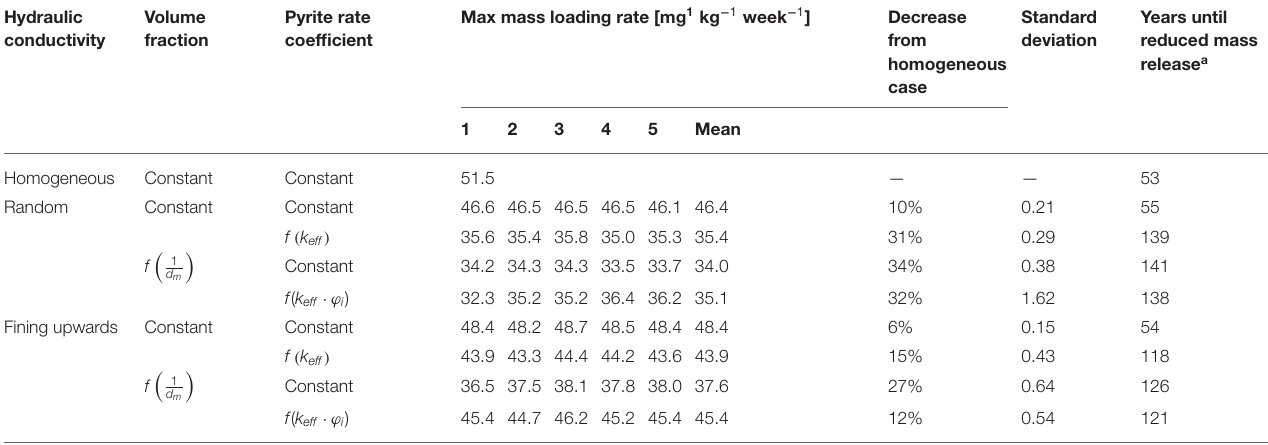
TABLE 3 | Variation in maximum mass loading rates and reduced sulfate release times with parameter heterogeneity. Hydraulic conductivity